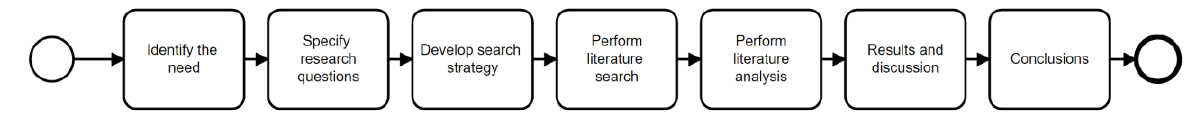
Figure 2. Main research phases according to